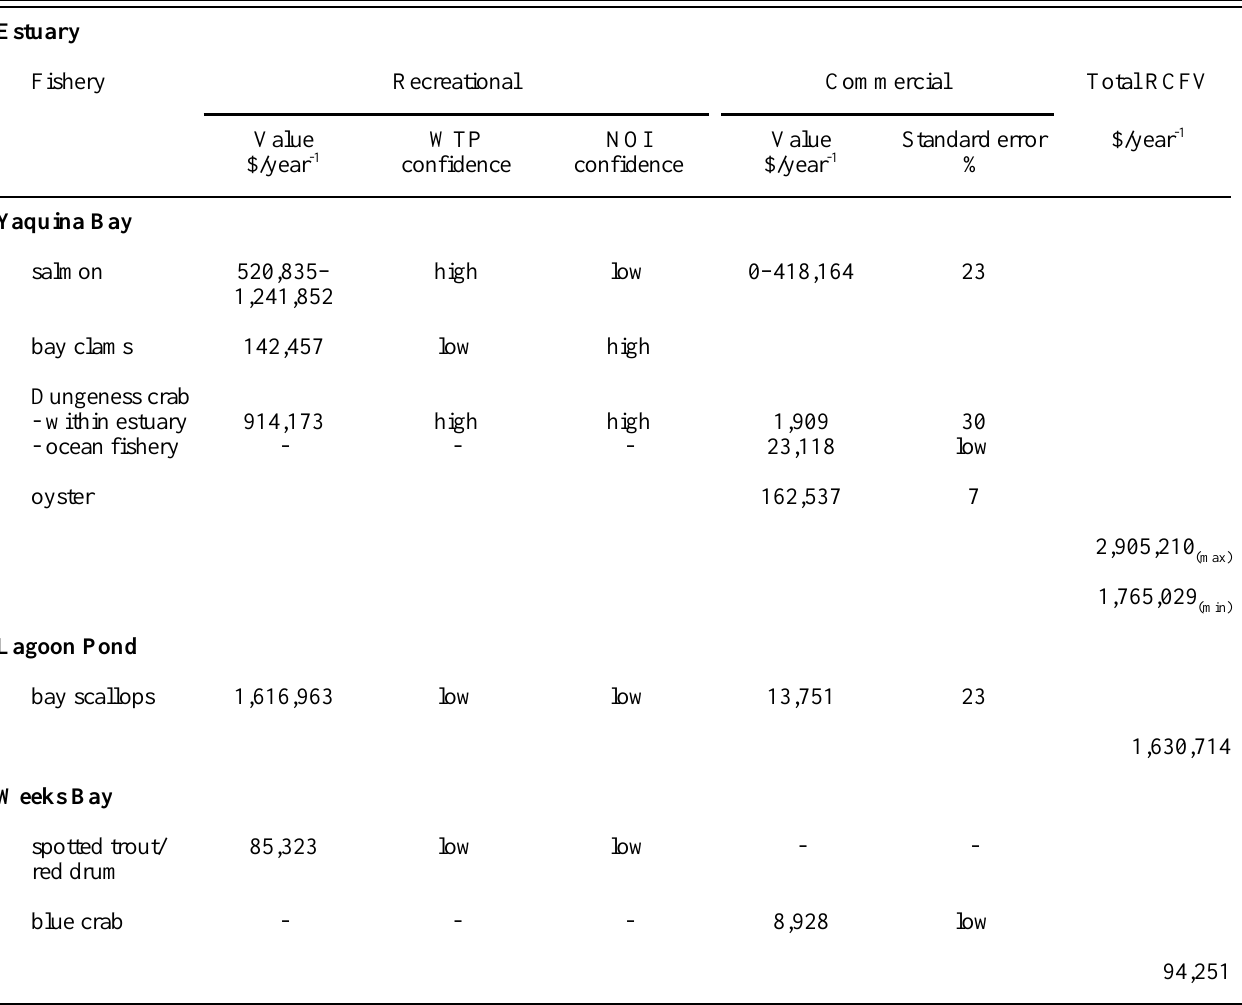
Table 3. Summary of results of the economic valuation study in each of the three estuaries with estimates of confidence in the data